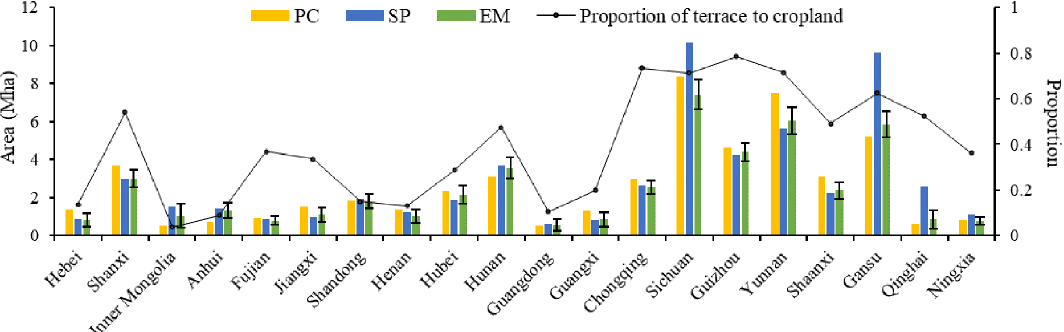
Figure 5. The terrace area and proportion in different provinces of China. The error bars indicate a 95% confidence interval. The proportion of terrace to cropland (cropland in GlobeLand30) was calculated by the pixel counting